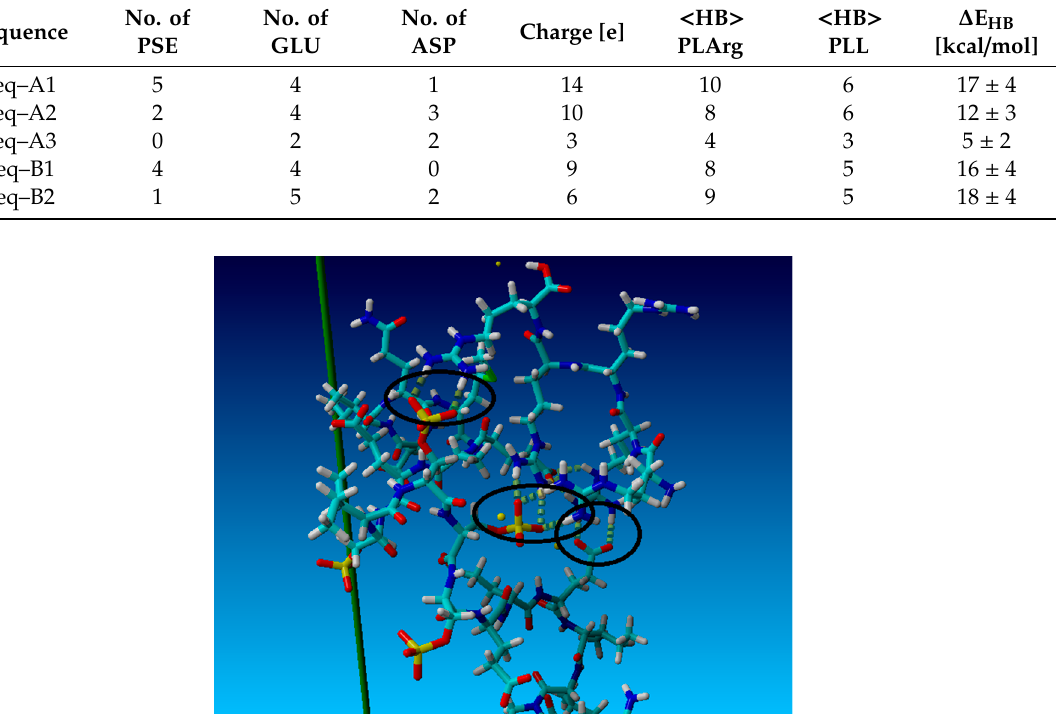
Table 4. The number of anionic residues, charge, the average number of hydrogen bonds formed by casein fragment with arginine and lysine oligomer and the di ff erence of the hydrogen bonding energy that resulted from the molecular dynamics simulations.